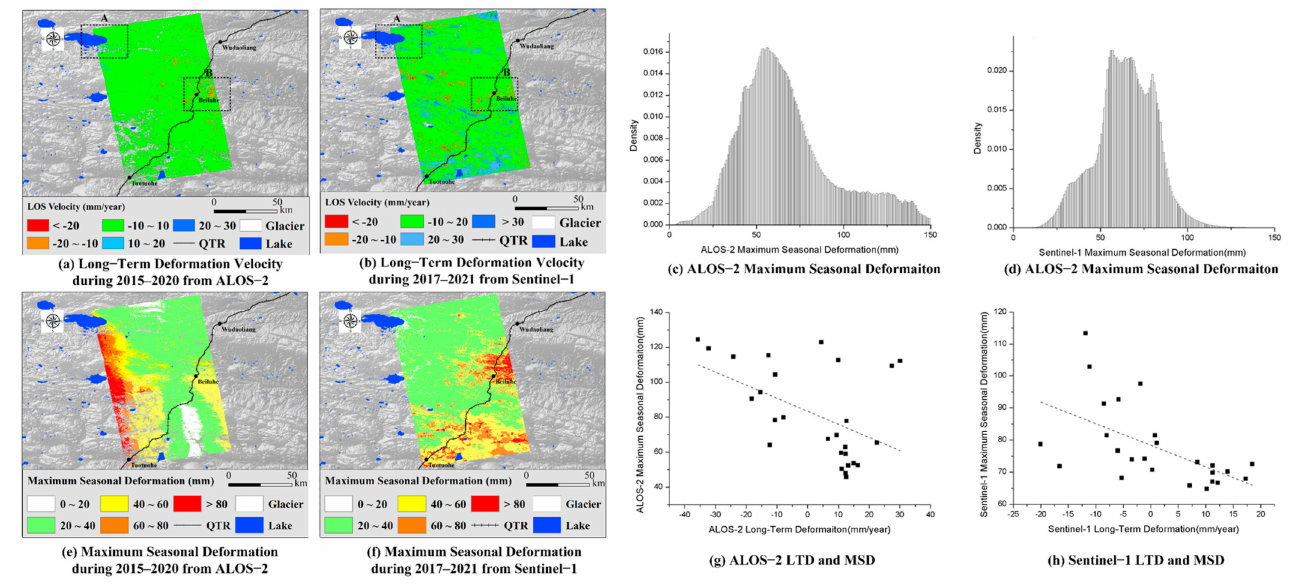
Figure 7. The long-term deformation velocity and maximum seasonal deformation. ( a ) Long- term deformation velocity during 2015–2020 from ALOS-2. ( b ) Long-term deformation velocity during 2017–2021 from Sentinel-1. ( c ) ALOS-2 maximum seasonal deformation. ( d ) Sentinel-1 maximum seasonal deformation. ( e ) Maximum seasonal deformation during 2015–2020 from ALOS-2. ( f ) Maximum seasonal deformation during 2017–2021 from Sentinel-1. ( g ) ALOS-2 LTD and